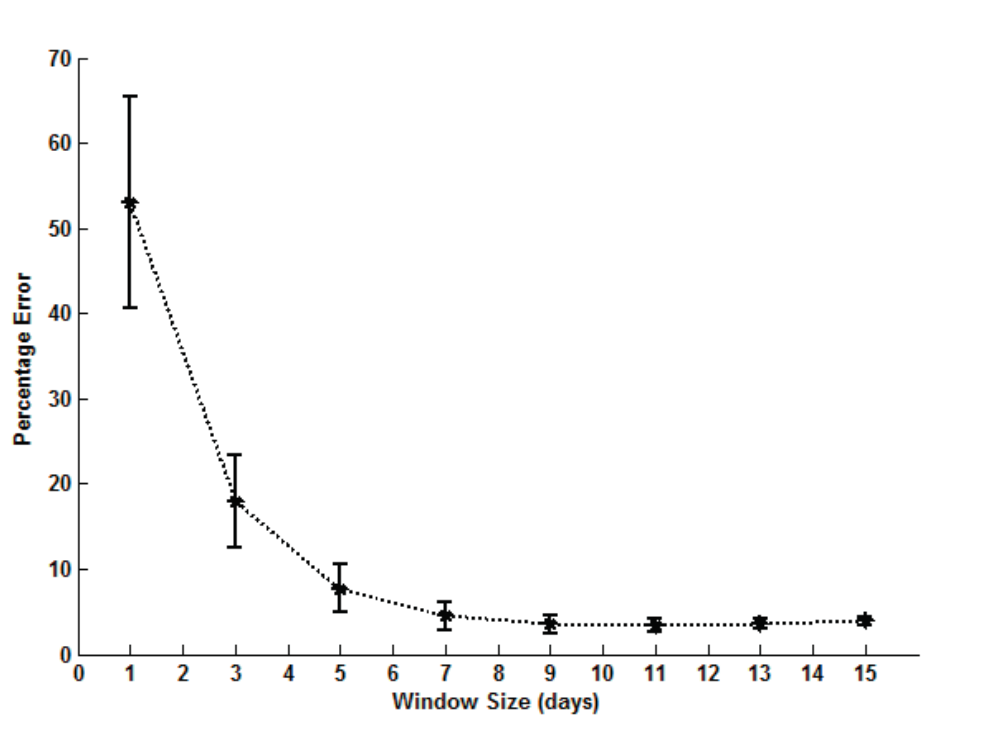
Figure 3. Mean absolute errors of snow cover percentage using a temporal filter with different window sizes. Vertical bars indicate the one standard deviation of the absolute errors with different window